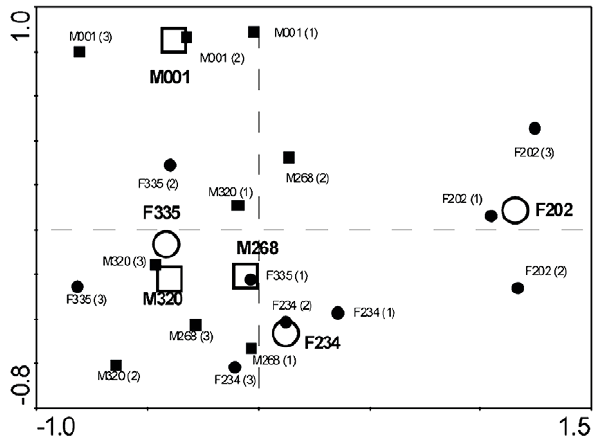
Figure 2. Ordination plot showing similarities between activity patterns of radio-tracked mole-rats. The Principal component analysis; numbers in parentheses indicate particular 72-h radio-tracking sessions, open symbols represent centroids of particular